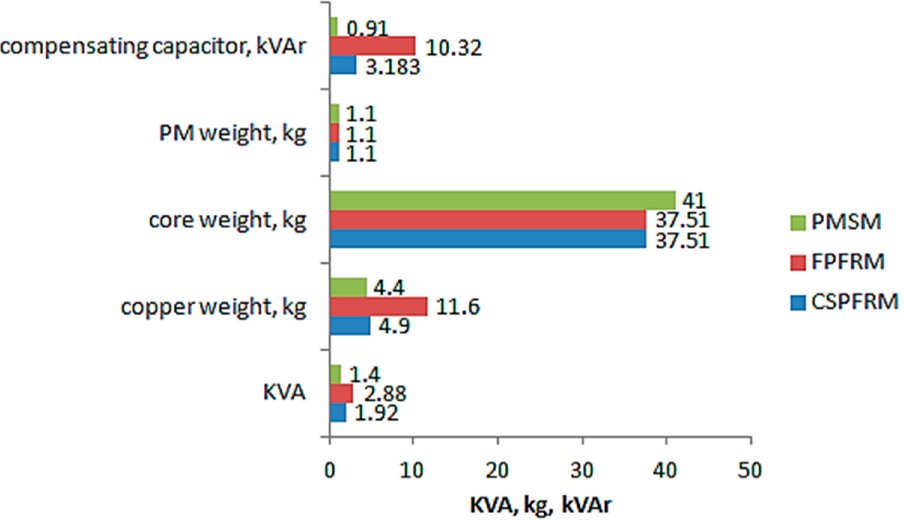
Figure 18. Comparison of Conventional Concentrated Stator Pole Winding Flux Reversal Machine (CSPFRM), Full Pitch Winding Flux Reversal Machine (FPFRM), and PMSM [134].